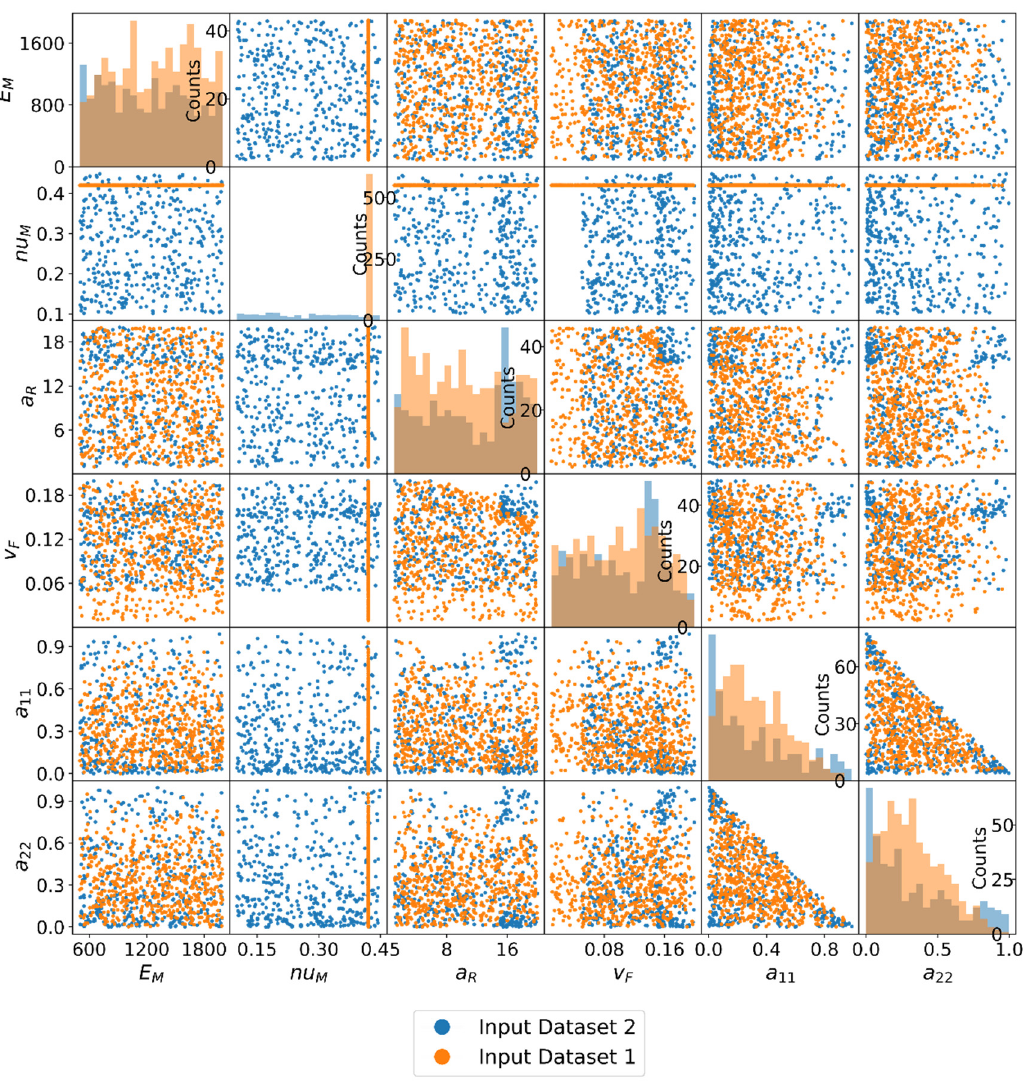
Figure 3. Correlation plot between all parameters of the RVE’s for two different input datasets. Dataset 1 features a constant Poisson’s ratio of the matrix material and Dataset 2 has a higher minimum fiber volume fraction.